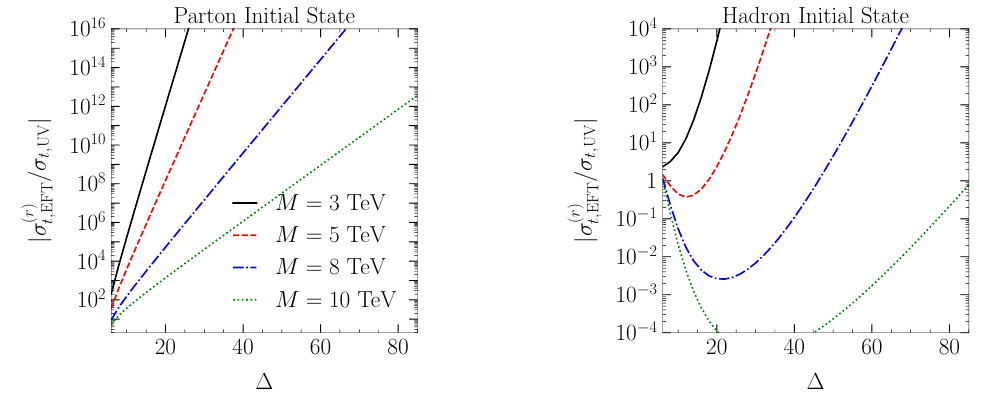
(cid:12) (cid:12) ( r ) /σ t, UV (cid:12) σ (cid:12) as a function of r . In the “Partonic Initial State” t, EFT √ ˆ s = 14 TeV; the term grows monotonically with r . In the “Hadronic √ s = 14 TeV; the term tends to decrease with r for small